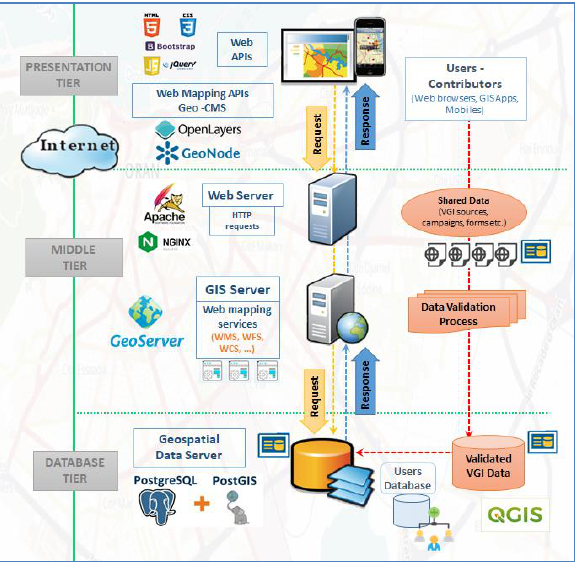
Figure 4 . Architecture adopted for the collaborative web mapping platform system.